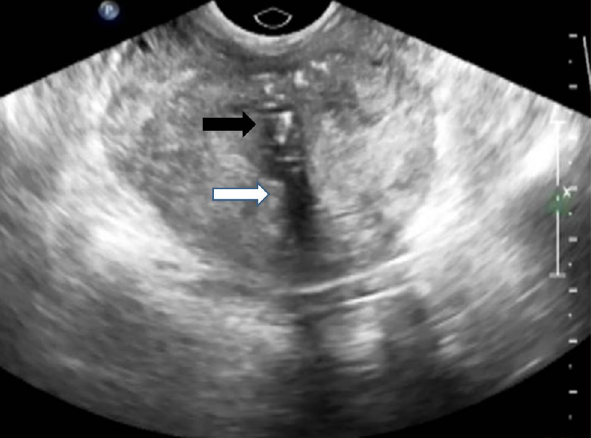
Figure 1. Prostatic calcifications with acoustic shadowing. Legend: The ultrasound image of patients with prostate calcification on the first clinic visit The prostate calcification appeared as the hyper echogeneous foci (black arrow). The acoustic shadowing appeared as the dark tail (white